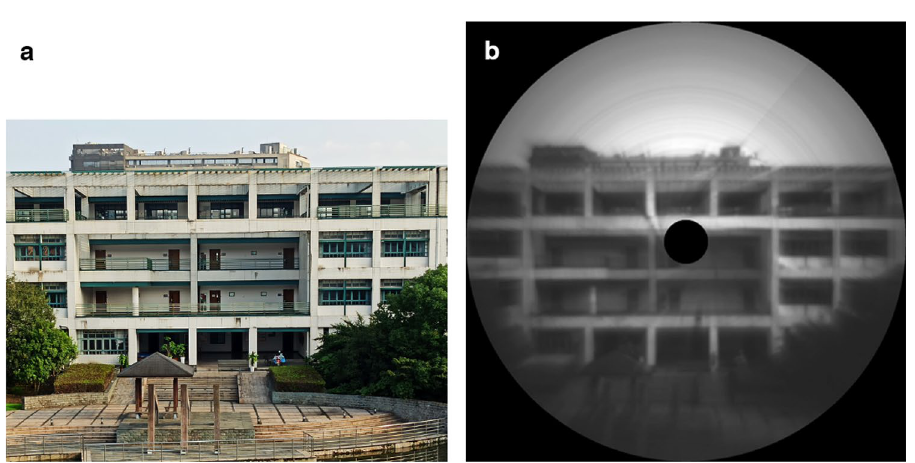
Figure 5. ( a ) Photo of a building; ( b ) image reconstructed by our rotational hyperspectral